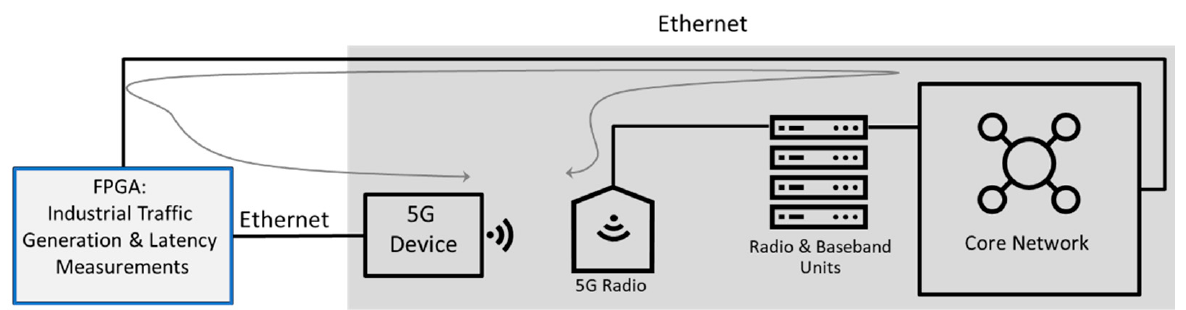
Figure 3. Measurement setup for on-premises 5G network on the shopfloor, where an FPGA-based tool is used for industrial traffic emulation and latency measurements. Source: Ericsson.